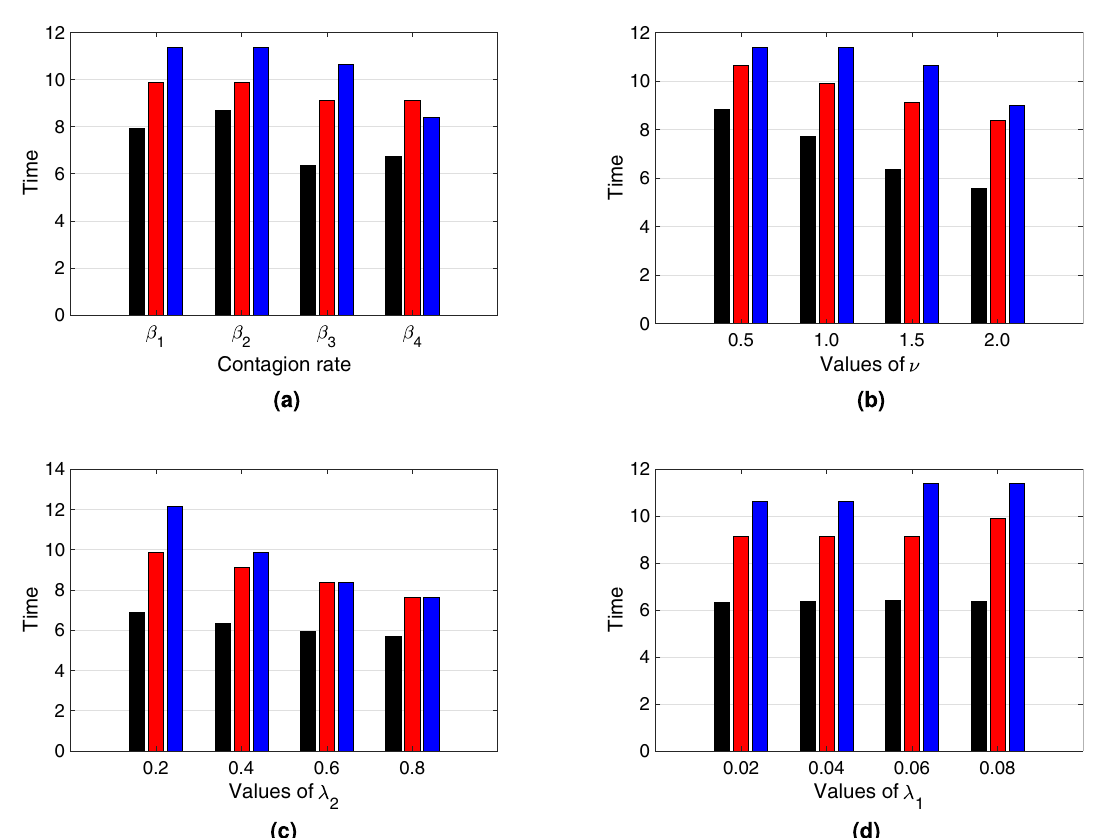
Figure 8. Time of occurrence of the peak of a first epidemic outbreak from the system in Eq. (1) with respect to, ( a ) contagion rates β i , i = 1, 2, 3, 4 , ( b ) measure of decrease of transmission rate with distance ν , ( c ) reaction velocity to change (cid:31) 2 , ( d ) rate of resistance to change (cid:31) 1 , for different society types: Black, red and blue bars correspond to D ∗ = 0.75 ( m ) , D ∗ = 1.05 ( m ) , and D ∗ = 1.35 ( m ) respectively. These correspond to societies of small ([0, 100)), medium ([100, 120]) and large ( [ 120, ∞ ) ) natural-distance types respectively (see Table 1). The height of each bar represents the time of occurrence of the peak of the epidemic curve. The other parameter values were taken to be β ∗ = 0.5 and γ = 0.2 . For ( a ) ν = 1.5 , (cid:31) 2 = 0.3 . For ( b ) we used β 3 ( D ) as the transmission rate, (cid:31) 1 = 0.03 and (cid:31) 2 = 0.3 . For ( c ) we also used β 3 ( D ) as the transmission rate, (cid:31) 1 = 0.03 and ν = 1.5 . For ( d ) (cid:31) 2 = 0.3 , ν = 1.5 and β 3 ( D ) as the transmission rate. The initial condition D ( 0 ) = D ∗ was used for each type of